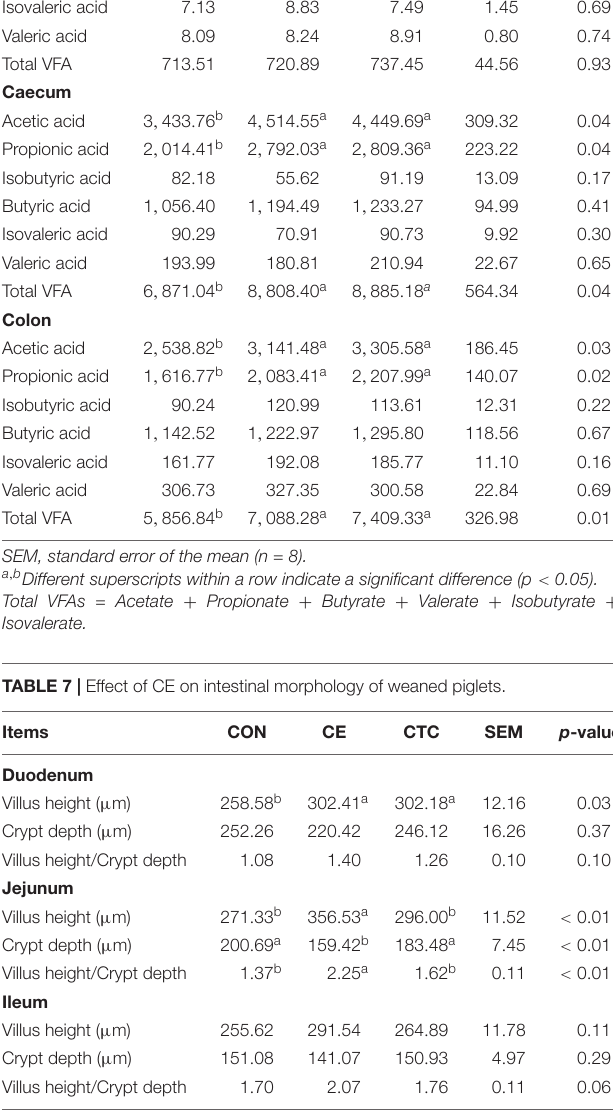
between CON, CTC, and CE groups was presented with PCoA ( Figure 1B ). The PCoA with the Bray–Curtis distance indicated that the samples of the CON group gathered together and clearly separated from the samples of the CE and CTC groups. At the phylum level ( Figure 2A ), the dominant phyla of cecum in three groups were Firmicutes and Proteobacteria .